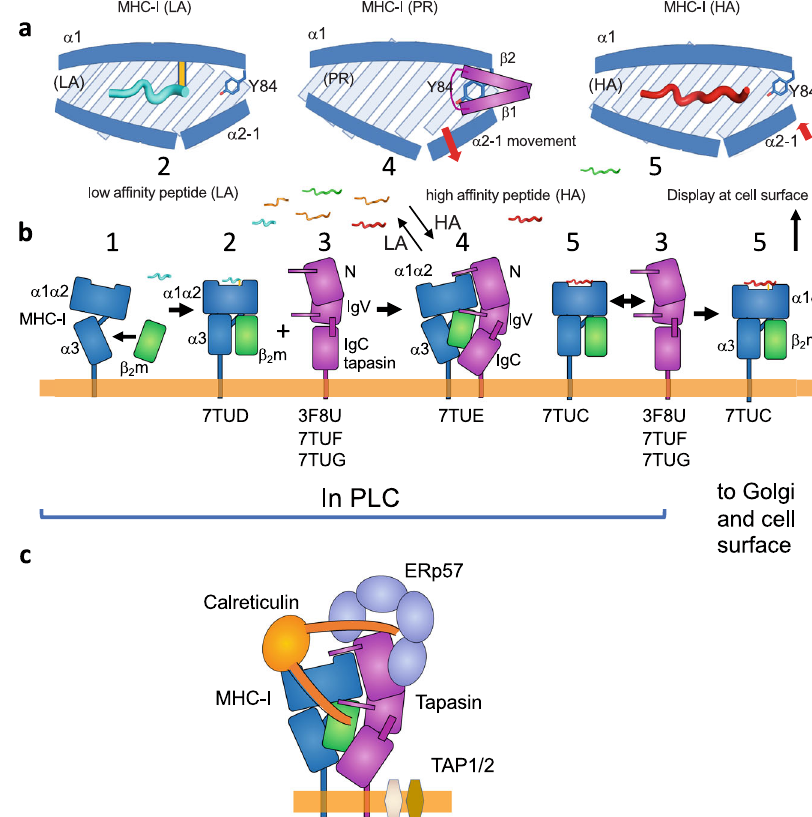
Fig.7|StructuresrepresentdistinctstatesofMHC-Iandtapasininthepeptide loading pathway. a cartoons representative of (left to right) MHC-I bound to low af fi nity (LA)peptide, MHC-I in complex with tapasin(peptidereceptive (PR) state), and MHC-I bound to high af fi nity (HA) peptide. b examples of distinct states of MHC-I – β 2 mandtapasin: 1 ,MHC-Iimmediatelyafterbiosynthesis,priortoengaging any peptide (represented by molecules immunoprecipitated by 64-3-7 49 , which identi fi es the unfolded conformation of the α 1 domain 3,10 helix 50 ); 2 , MHC-I